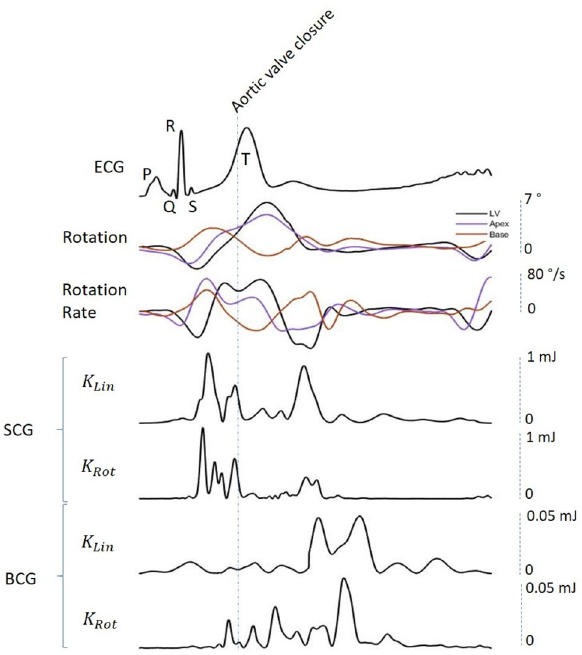
Figure 1. Synchronization of SCG and BCG signals with LV twist. From top to bottom: ( a ) ECG with the P-Q- R-S-T waves labeled; ( b ) LV twist, apical and basal rotations; ( c ) angular rates of LV twist, apical and basal twist rotations; ( d ) K Lin SCG; ( e ) K Rot SCG; ( e ) K Lin BCG; ( f ) K Rot BCG. The first of the two main peaks of K Lin SCG ( d ) and K Rot SCG ( e ) occurs before the aortic valve closure (AVC), during the ejection phase of cardiac cycle and concomitantly with the acceleration of LV twist; the second one occurs after the AVC, synchronously with the deceleration phase of LV twist. With regards to the BCG, waves of K Lin and K Rot occur almost exclusively after the AVC, during the diastolic phase of cardiac cycle. The Aortic Valve Closure (AVC) is labeled on the figure. K Lin kinetic energy in the linear dimension, K Rot kinetic energy in the rotational dimension, SCG seismocardiography, BCG ballistocardiography, ECG electrocardiogram, LV left